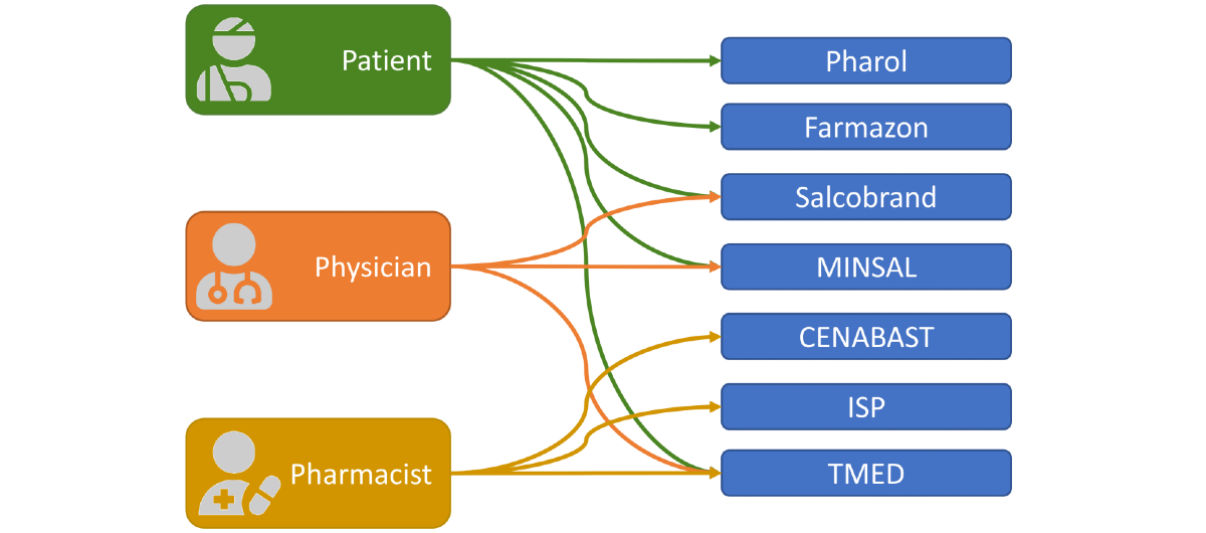
Figure 2. Graphical representation of the patient (green), physician (red), and pharmacist (yellow) user groups and their assigned online consumer medication information systems. Online system types include online pharmacies (Pharol, Farmazon), a traditional pharmacy (Salcobrand), medication information aggregators (MINSAL), medication information platforms (CENABAST, ISP), and a self-developed platform (TMED). CENABAST: National Health Service System of Chile; ISP: Public Health Institute of Chile; MINSAL: Ministry of Health of Chile; TMED: medication